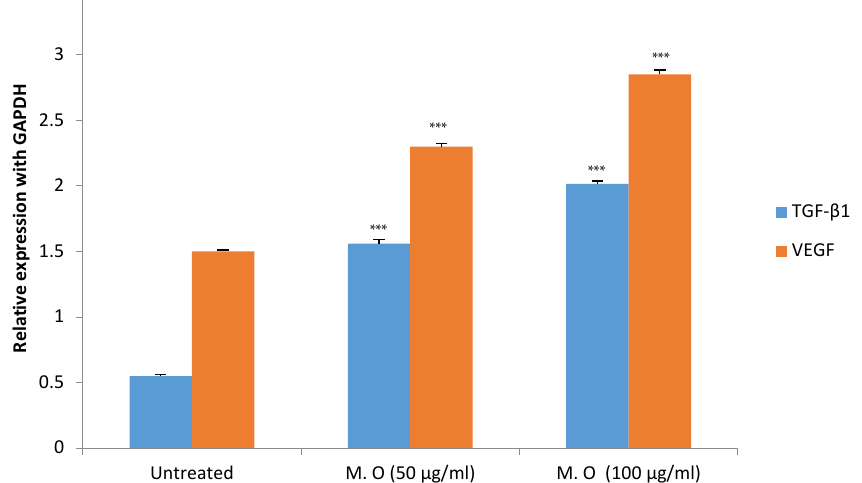
Figure 13. Effect on the expression of TFG- β 1 and VEGF genes in HaCaT cell line under high glucose. All values are mean ± SEM, n = 6, *** p < 0.001 when compared to untreated cells.